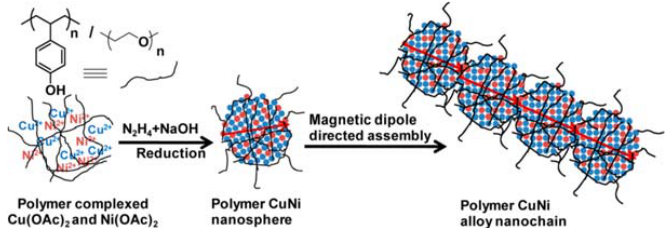
Figure 5. Preparation of CuNi polymer ‐ assisted chain ‐ like alloy nanostructures. Reprinted